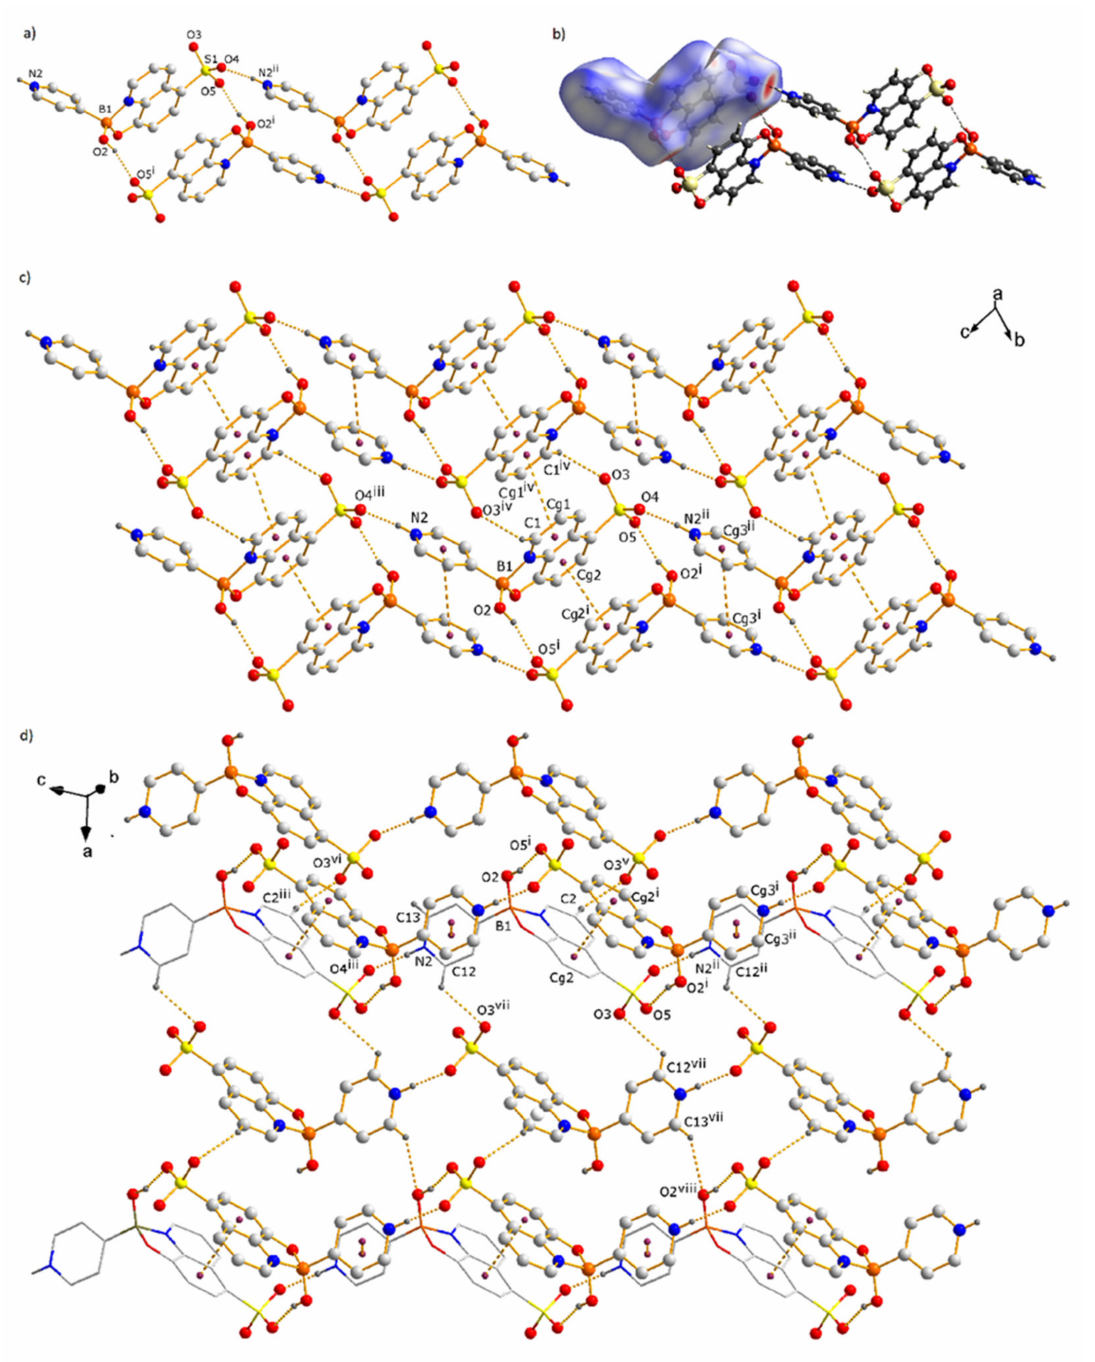
Figure 4. Fragments of the crystal structure and Hirshfeld surface map of compound 2 , showing hydrogen-bonding motifs and π – π interactions ( a – d ). Symmetry operators: (i) 1-x,2-y,1-z; (ii) x,1+y, − 1+z; (iii) x, − 1+y,1+z; (iv) 1-x,1-y,1-z; (v) − 1+x,y,z: (vi) − 1+x, − 1+y,1+z; (vii) 2-x,1-y,1-z; (viii) 2+x,y, −